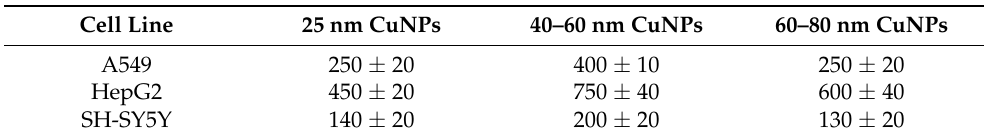
Table 1. Copper uptake analysis was performed on cell pellets treated with CuNPs for 24 h in cell culture media. Values reported are in ng copper/10 6 cells with calculated standard errors from three repeated